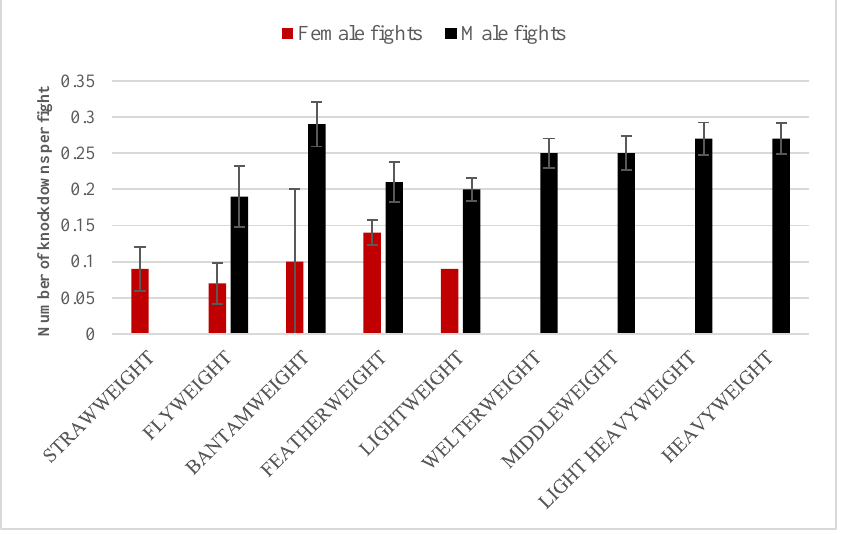
Figure 3. Number of knockdowns per fight in female (red) and male (black) fights. The error bars present standard errors.